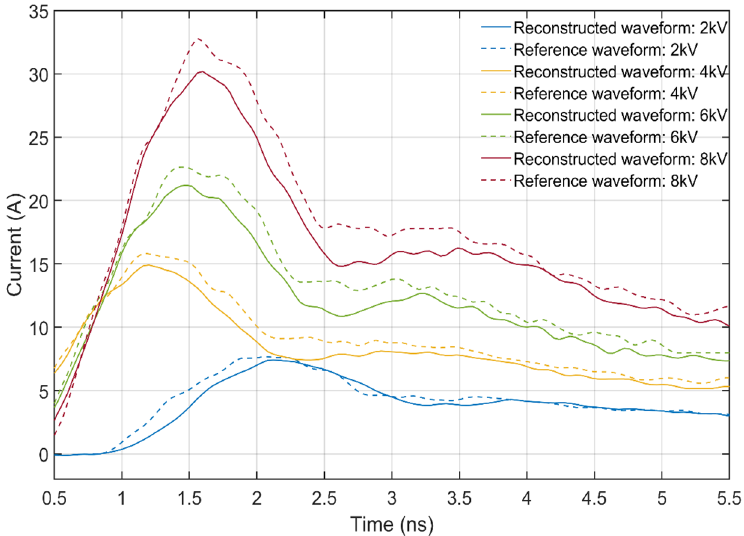
Figure 17. Initial peak comparison of the reconstructed waveform (straight lines) with the Pelle- grini target (reference) waveform (dotted lines) for a +2 kV (blue), +4 kV (yellow), +6 kV (green) and +8 kV (red) pulse of the EMC Partner Transient 3000 generator.